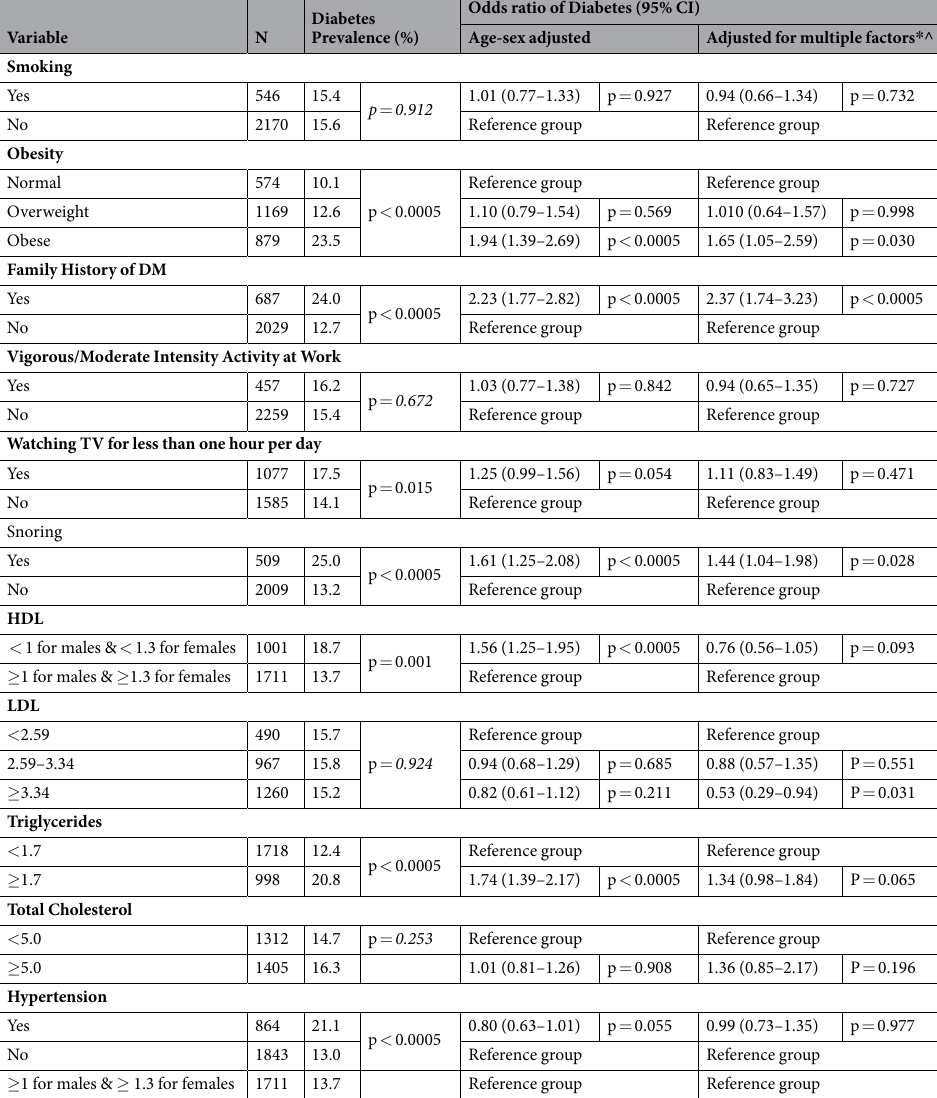
Table 3. Prevalence and Adjusted Odds ratio of Diabetes by Biomedical Risk Factors. * Adjustment was made for age, gender, employment, ethnicity, education and income. ^Omnibus test model ( χ 2 = 247.577, p <